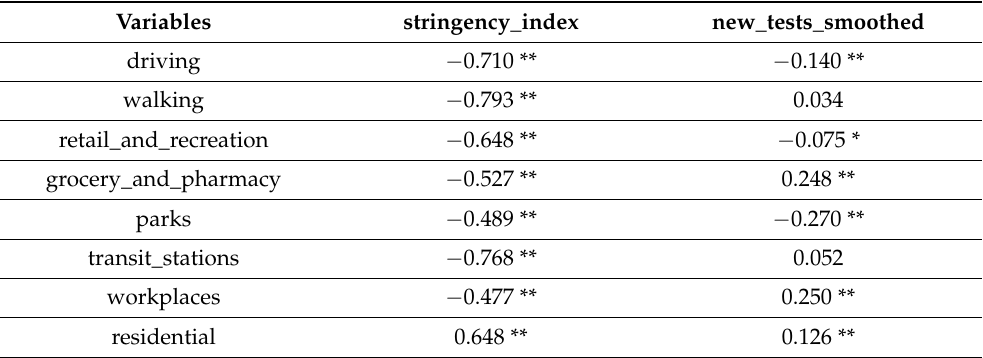
Table 3. Spearman’s r s correlation indexes calculated between variables indicating restrictions and mobility in